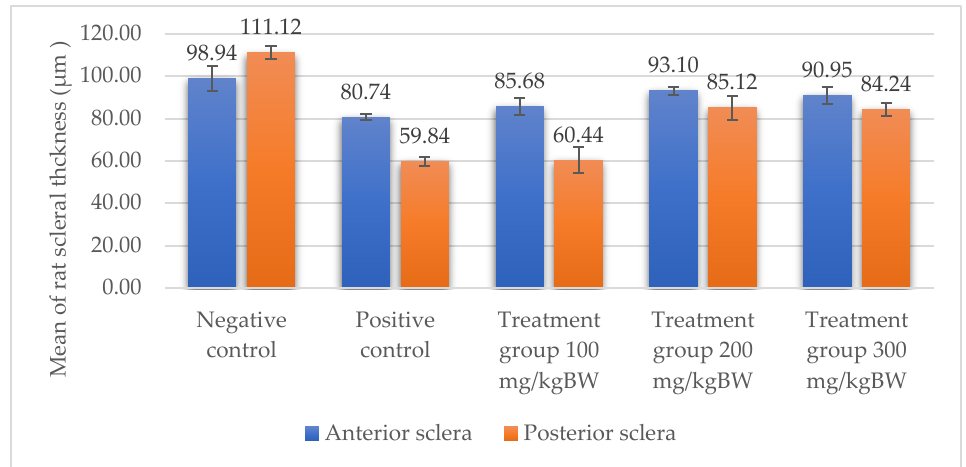
Figure 4. Mean thickness of the rats’ scleral tissue. From Tukey test, we found that the negative control group shows greater thickness in the anterior sclera and posterior pole compared to the positive control group (98.94 ± 6.06 µ m vs. 80.74 ± 1.39 µ m, p = 0.002 in the anterior sclera and 111.12 ± 2.99 µ m vs. 59.84 ± 2.02 µ m, p = 0.000 in the posterior pole). The treatment groups administered with 200 mg/kg BW/day (93.10 ± 1.93 µ m vs. 80.74 ± 1.39 µ m, p = 0.002 in the anterior sclera and 85.12 ± 5.62 µ m vs. 59.84 ± 2.02 µ m, p = 0.000 in the posterior pole) and 300 mg/kg BW/day (90.95 ± 4.07 µ m vs. 80.74 ± 1.39 µ m, p = 0.000 in the anterior sclera and 84.24 ± 3.15 µ m vs. 59.84 ± 2.02 µ m, p = 0.000 in the posterior pole) show significant differences compared to the positive control